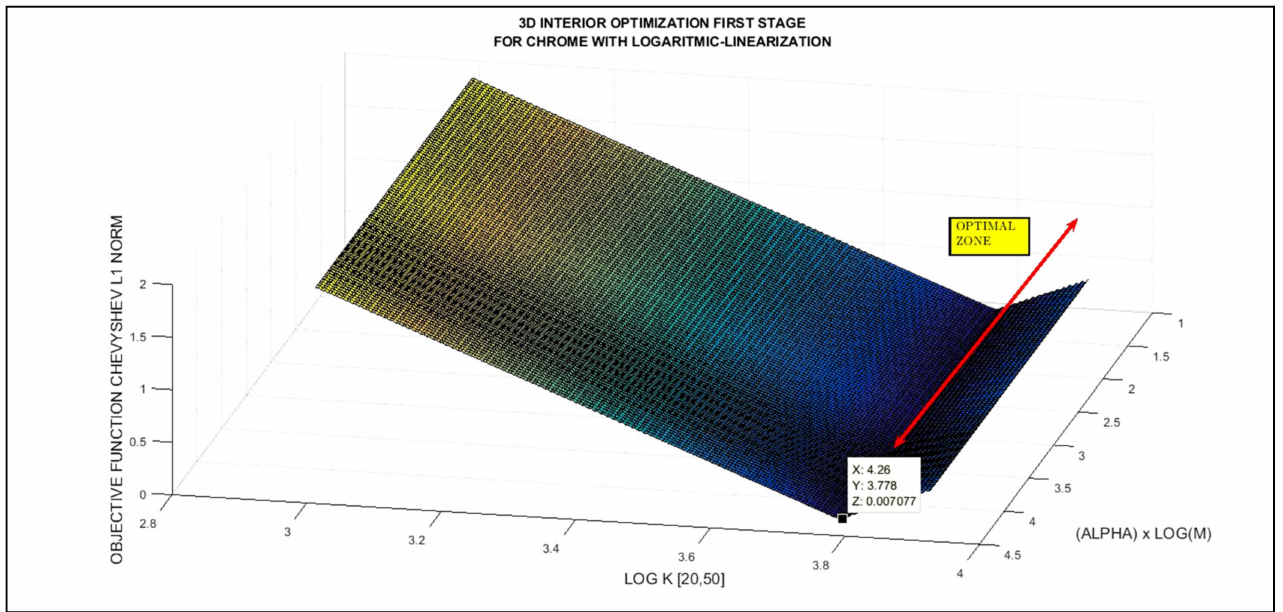
Figure 4. Chrome first stage of 3D interior optimization. Optimal zone is accurate and OF magnitude is about 7 × 10 − 3 . This value validates the chrome GA results. Optimal zone marked inset. Image processing method 1.